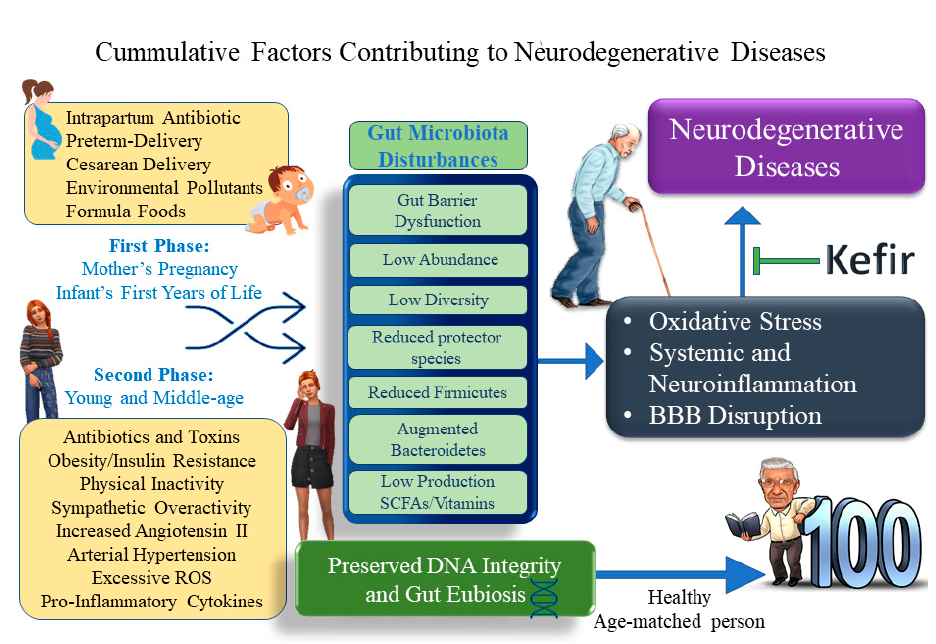
Figure 2. Schematic diagram suggesting several negative factors (conventional and nonconventional) that influence the seeding of the gut microbiota (as identified by “omics” approaches) in the early days of life of the infant and that can anticipate the onset of AD and PD. In addition to searching for the negative factors influencing ND, in our opinion, we suggest that the search in this field should also be expanded to the features (biomarkers, epigenetic influence) that could explain those that are centenarian life spans. This diagram was also created by one of the coauthors of this review, a 76-year-old researcher suffering from PD for 12 years.